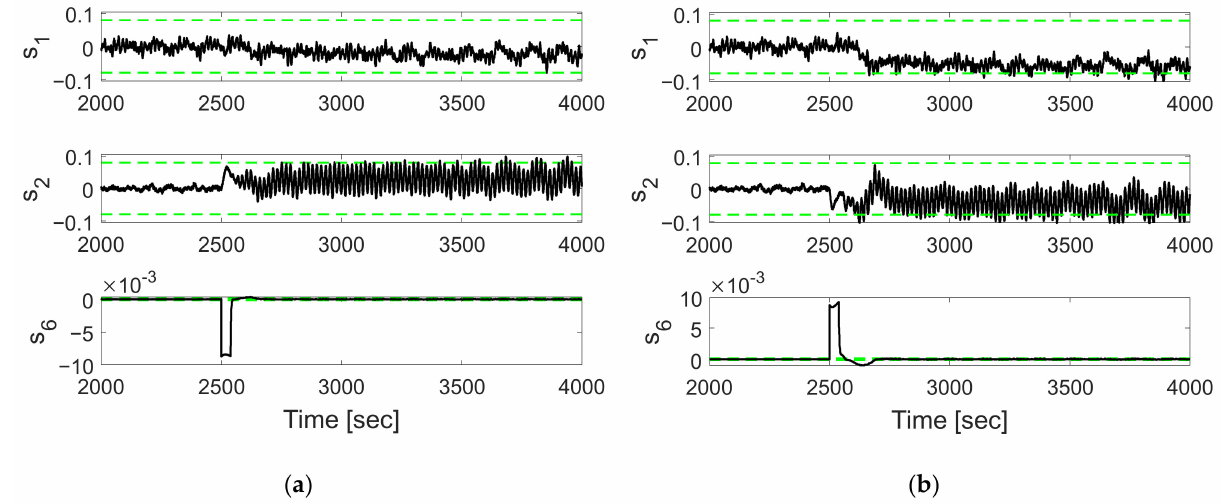
Figure 14. Responses of the sliding surface of the SM controller depending on the control scenario: ( a ) case 1 and ( b ) case 2.